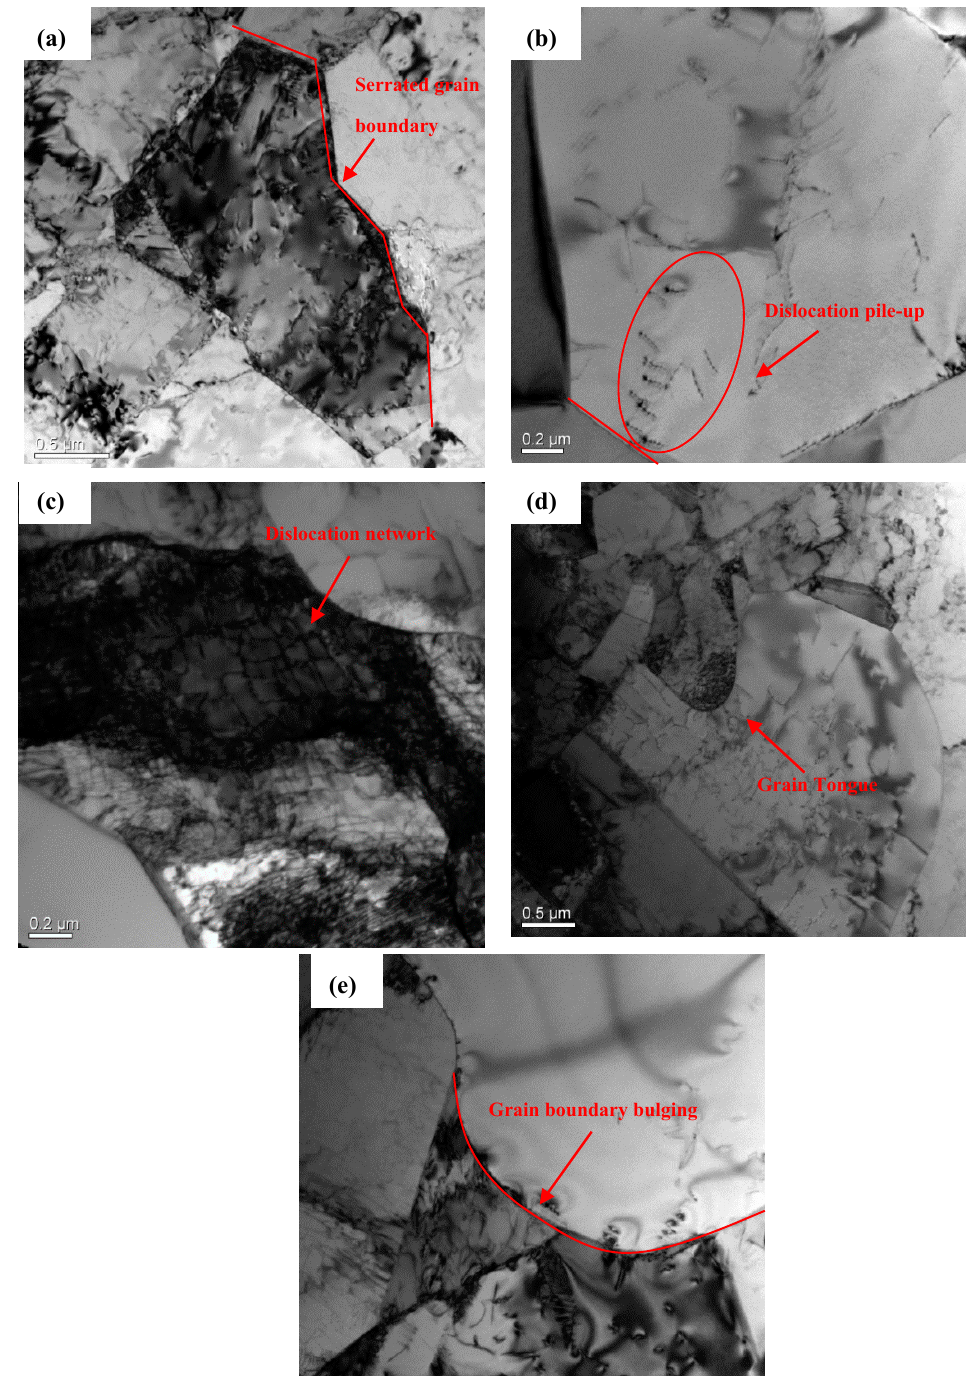
Figure 14. TEM micrographs of dislocation substructures and DRX nucleation in HY282 alloy at: ( a ) 960 °C/10 s − 1 , ( b , c ) 1000 °C/0.1 s − 1 , ( d ) 1000 °C/1 s − 1 , ( e ) 1120 °C/1 s − 1 . TEM micrographs of dislocation substructures and DRX nucleation in the alloy are shown